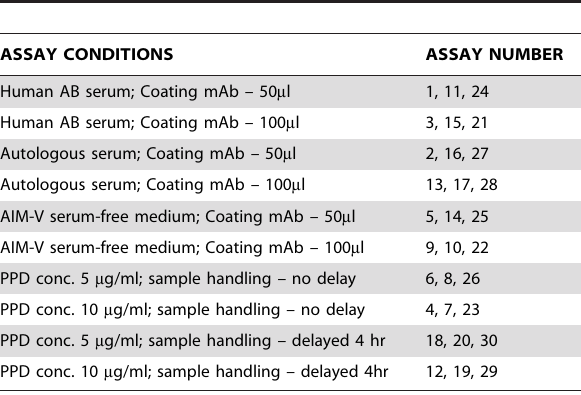
Table 2. Description of assays represented in Figure 5 for which each laboratory provided separate spot